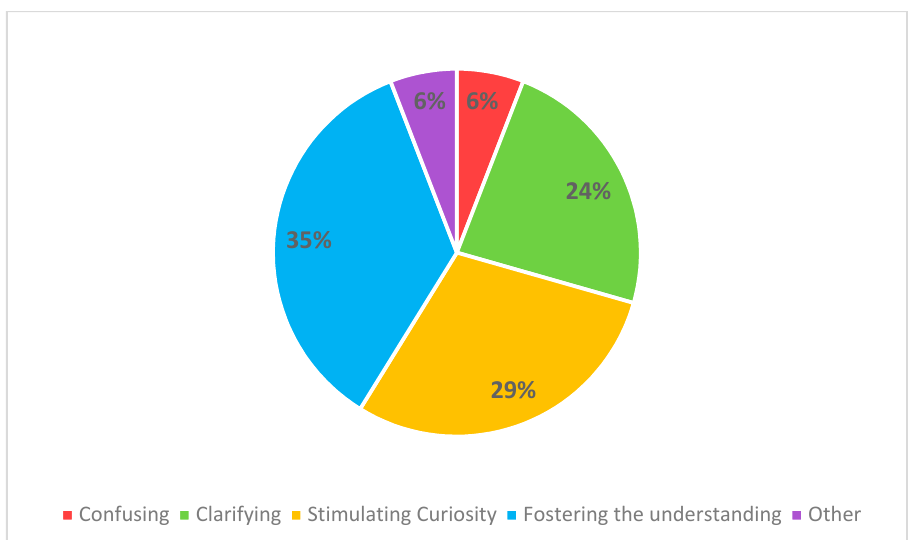
Figure 7. Assessment of the representation of 3D buildings using buildings with blue color scale appearing and disappearing through